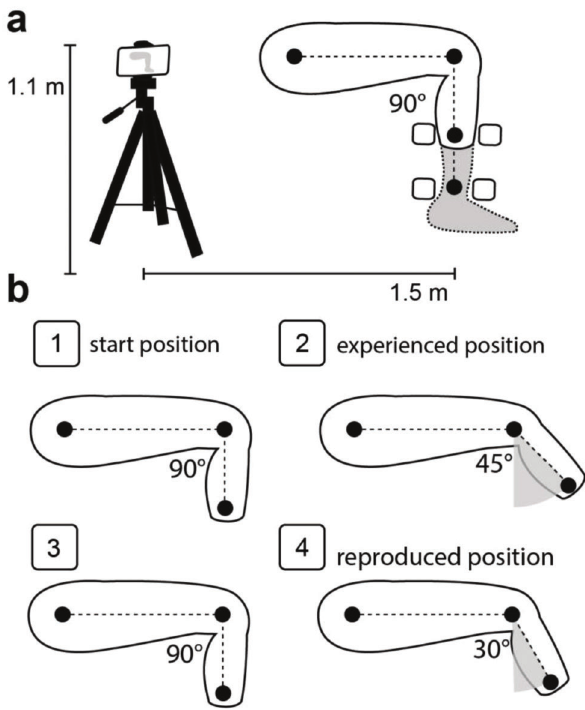
Figure 1 - Overview of the experimental conditions. a) Repre- sentative set-up to video recording during the joint position sense and strength evaluation. The black circles represent the Styrofoam balls used to measure distance and angles. The squares represent the positions used to set the hand-held dyna- mometer. b) Step-by-step representation of the joint position sense, b-1: demonstrated the start position B 90 o of knee flexion, b-2: the experienced position, b-3: the subject returning to the start position and waiting for the evaluator ’ s subsequent commands, b-4: the reproduced position. The difference between the reproduced and experienced positions were used for calculating proprioception indices. The angles 45 o and 30 o are example